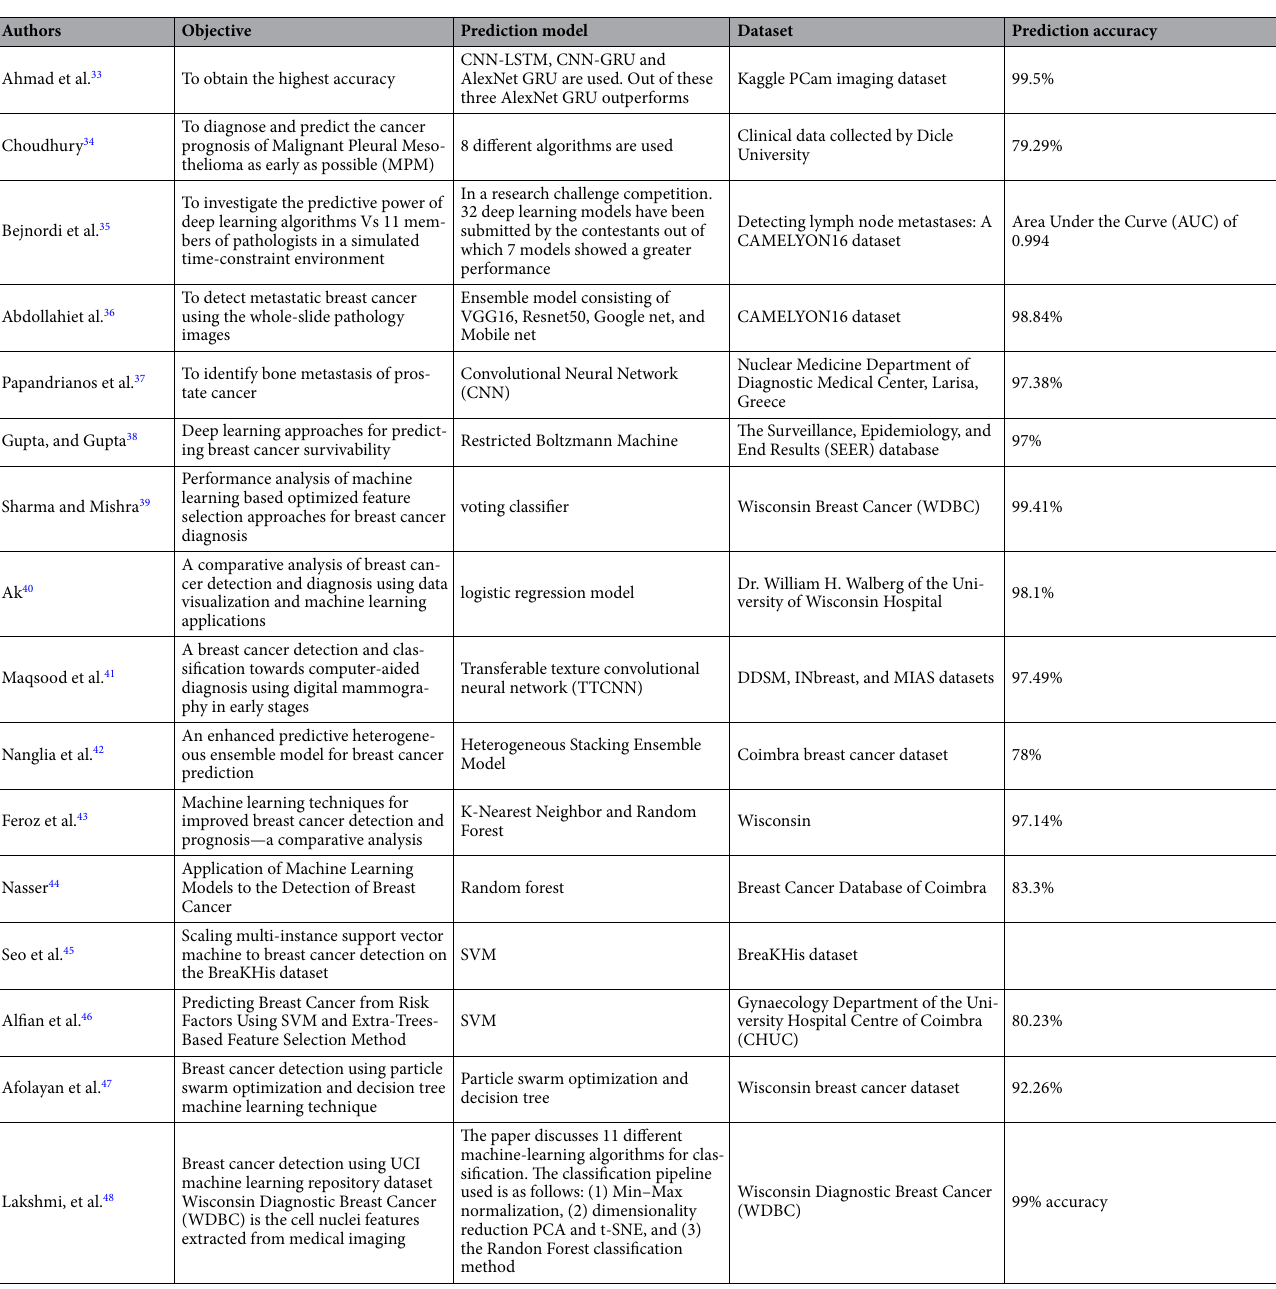
Table 1. Metastatic and cancer prediction